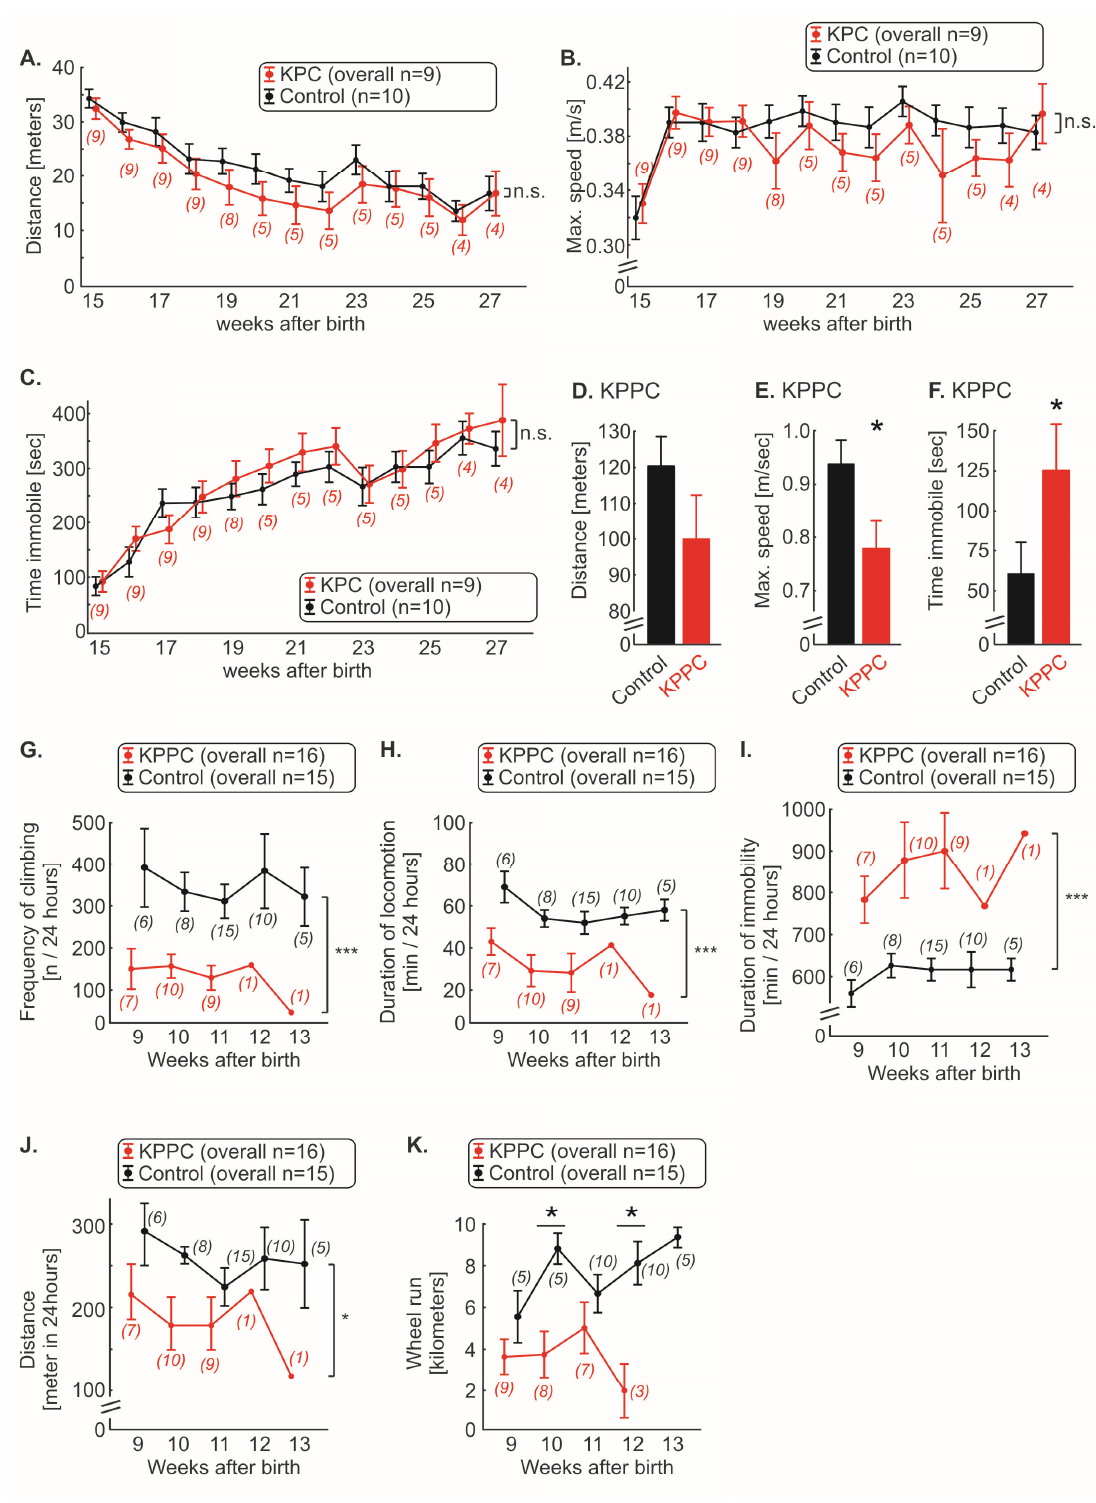
Figure 5. KPPC mice, but not KPC mice, show reduced well-being. ( A – F ). Behavioral analyses in the open field test. KPC mice ( A – C ) were tested weekly, and running distance in 10 min ( A ), maximum speed ( B ) and time immobile ( C ) was plotted. KPPC mice were tested at a single time point (9–10 weeks after birth) because they died soon after the start of the experiment ( D – F ). Running distance in 10 min ( D ), maximum speed ( E ) and time immobile ( F ) were determined (KPPC: n =